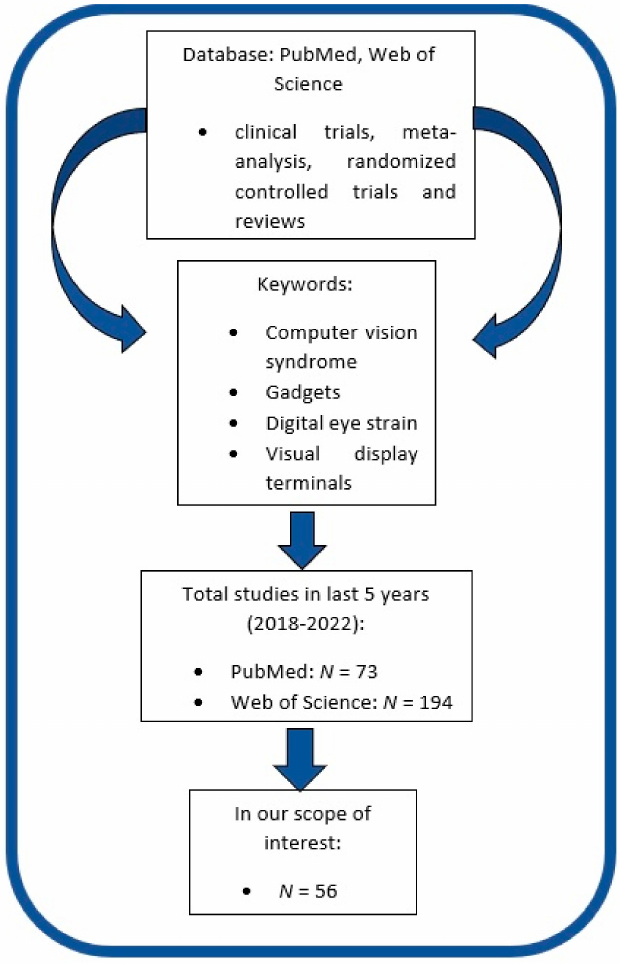
Figure 1. A schematic representation of the current study